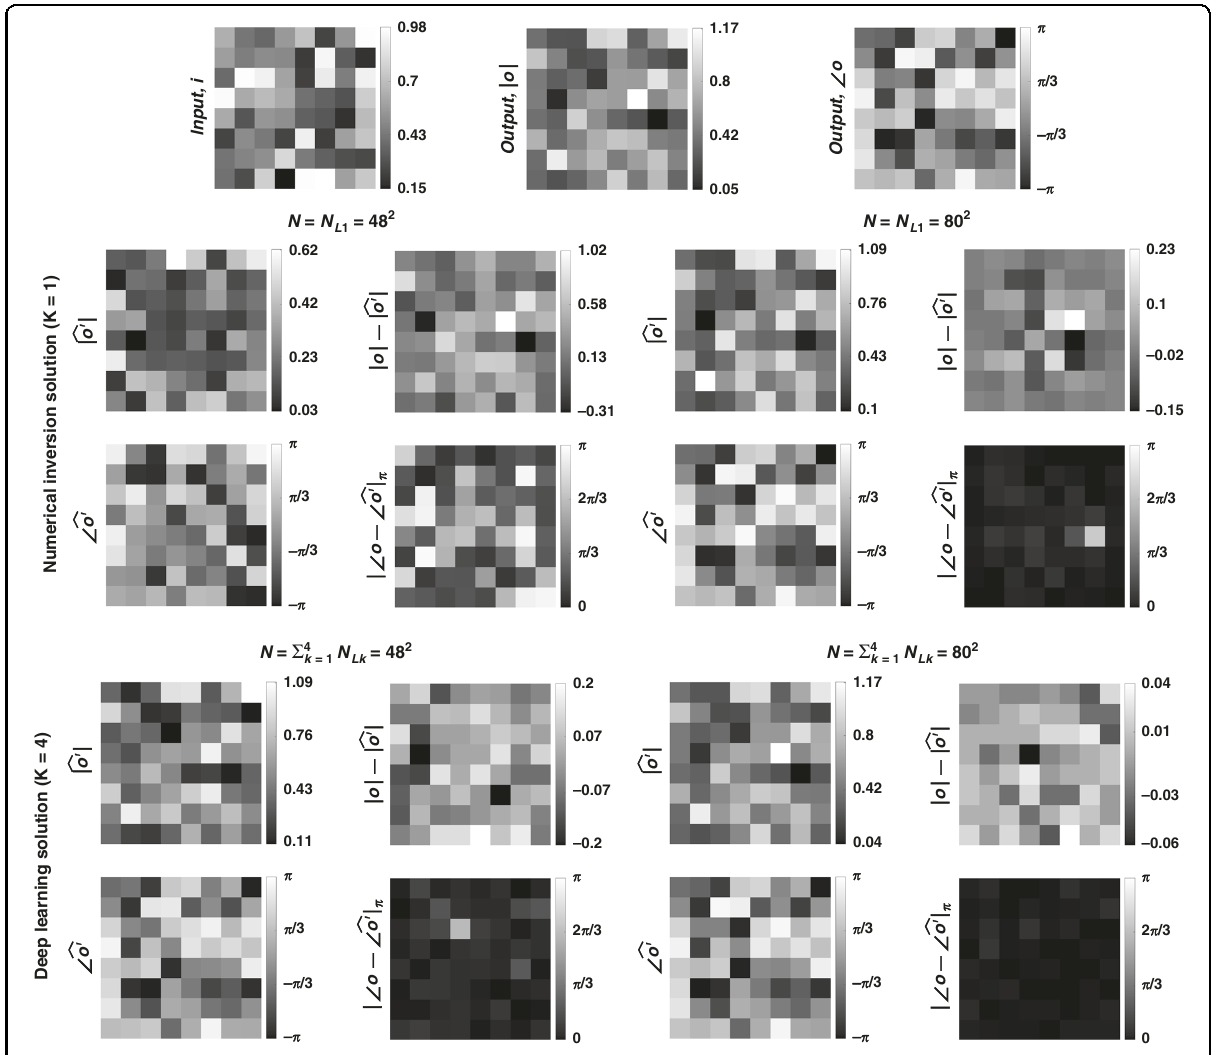
Fig. 3 Sample input-output images for the ground truth transformation presented in Fig. 1b and the optical outputs by the diffractive designs for two different choices of N ( N = 48 2 and N = 80 2 ). The magnitude and phase of the normalized output fi elds and the differences of these quantities with respect to the ground truth are shown. ff o (cid:2) ff b o ′ normalized output fi